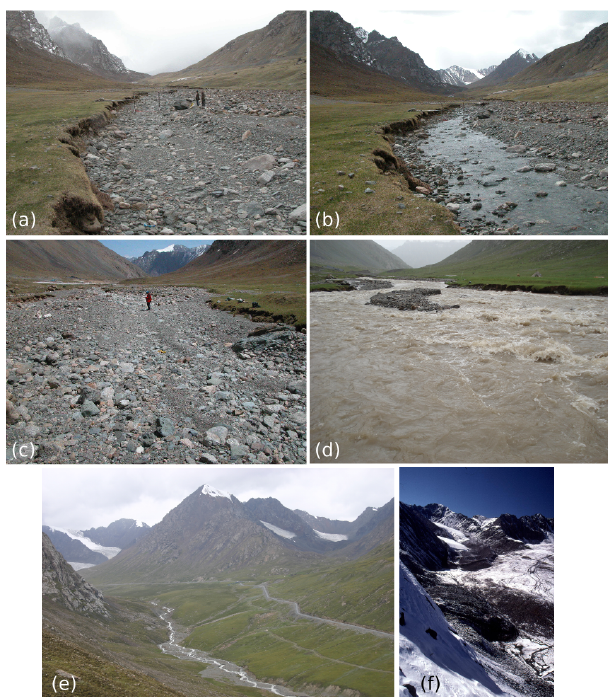
Fig. 2. Channel morphology of the Urumqi River. The Urumqi River originates from the Tangger Glacier located on the northern flanks of the Tianshan range: (a) Site 1-2, view upstream on 16 May 2006 when the channel is dry. (b) Site 1-2 during the rise of the water level on 17 May 2006. (c) Site 1-1 on 16 May 2006, looking downstream. (d) Site 1-1 during the flood of 3 July 2006. (e) General view of the Urumqi glacial valley towards Tangger peak (in the back). (f) Source glaciers of the Urumqi River with moraines in the